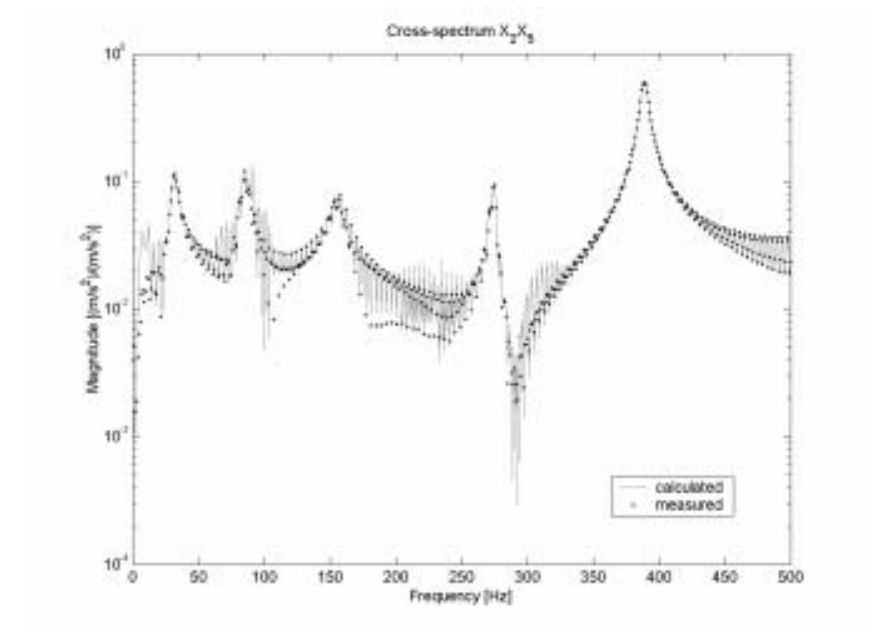
Fig. 6. Calculated and measured spectral